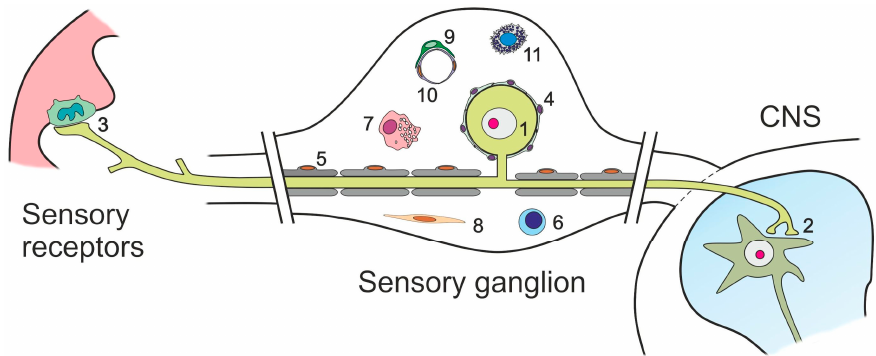
Figure 2. Diagram showing the cellular components of sensory ganglia: (1) cell body of a primary sensory neuron; (2) synaptic boutons from the central projection of the sensory neuron, contacting a second-order neuron in the spinal cord or the trigeminal nuclei of the brain stem; (3) terminal ending of a peripheral branch of the sensory neuron, contacting a skin receptor (Merkel) cell; (4) satellite glial cells, tightly enclosing the cell bodies of sensory neurons; (5) Schwann cells and myelin sheaths; (6) resident T-lymphocyte; (7) resident macrophage; (8) endoneurial and perineurial fibroblast-like cells;